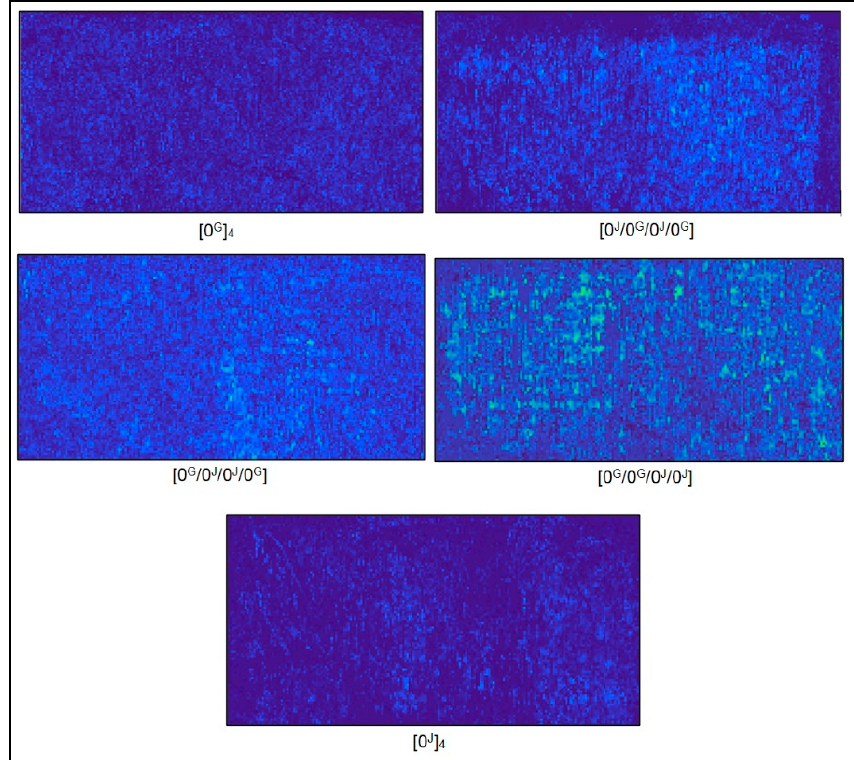
Figure 2. C-scan maps obtained for the studied laminates.